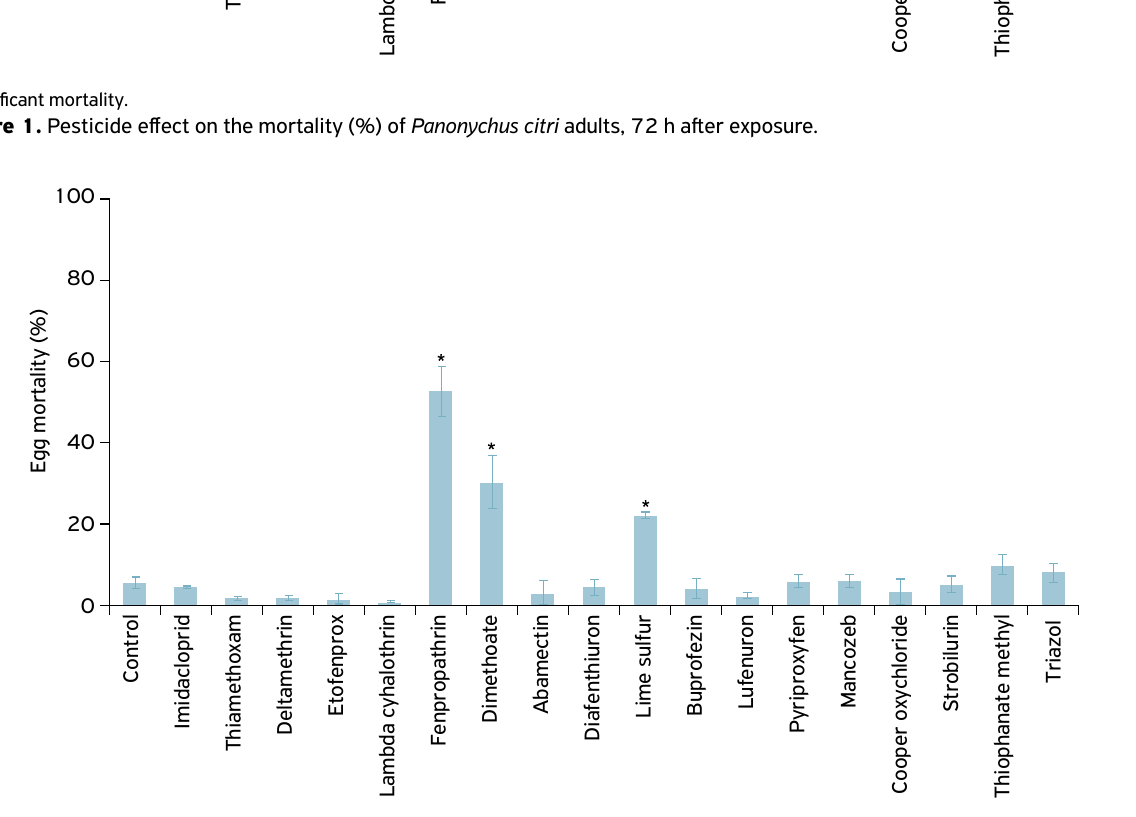
Figure 2. Pesticide effect on the egg mortality (%) of Panonychus citri